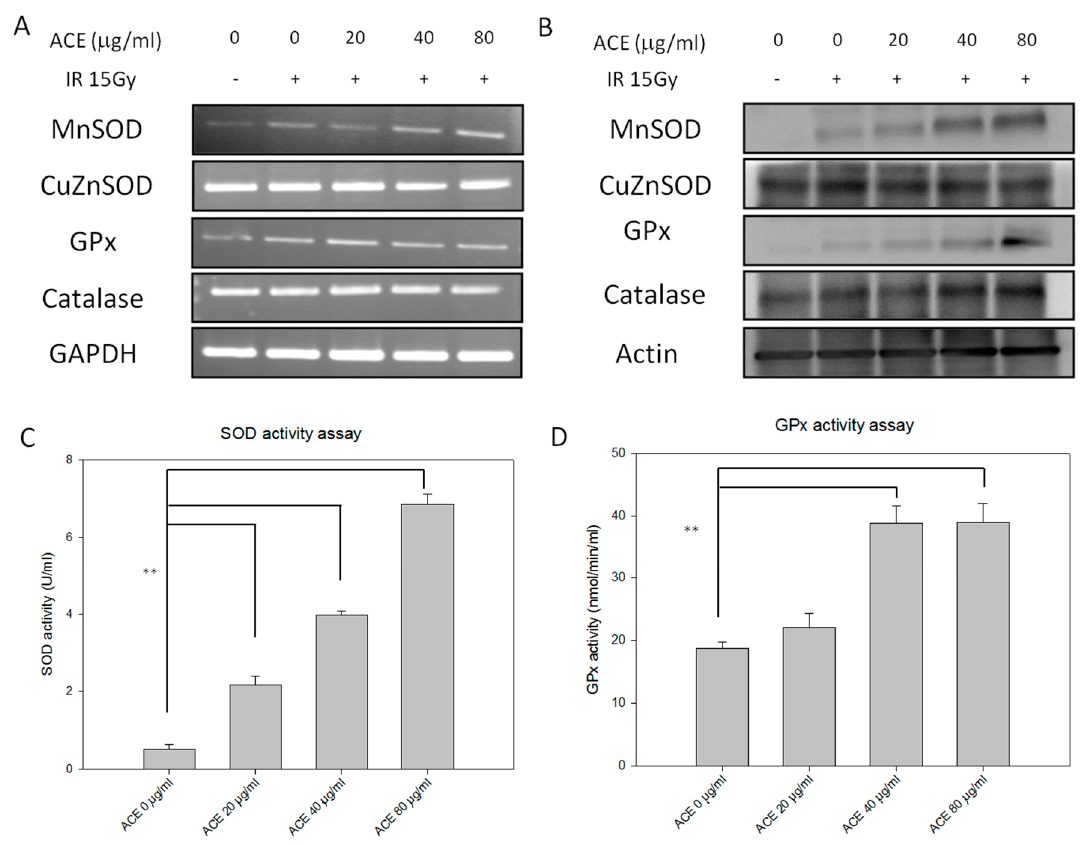
Figure 5. Redox-related enzymes expression and activity profiles of CL48 hepatocytes after IR and/or ACE treatments. With or without ACE pre-treatment for 16 h, cells were irradiated with a dose of 15 Gy and harvested 24 h later for RT-PCR ( A ), Western blot ( B ), total superoxide dismutase (SOD) activity ( C ), and glutathione peroxidase (GPx) activity ( D ) analyses. Results were obtained from three independent experiments, each experiment was done in triplicate. **, p < 0.01, as compared with the control IR only group.